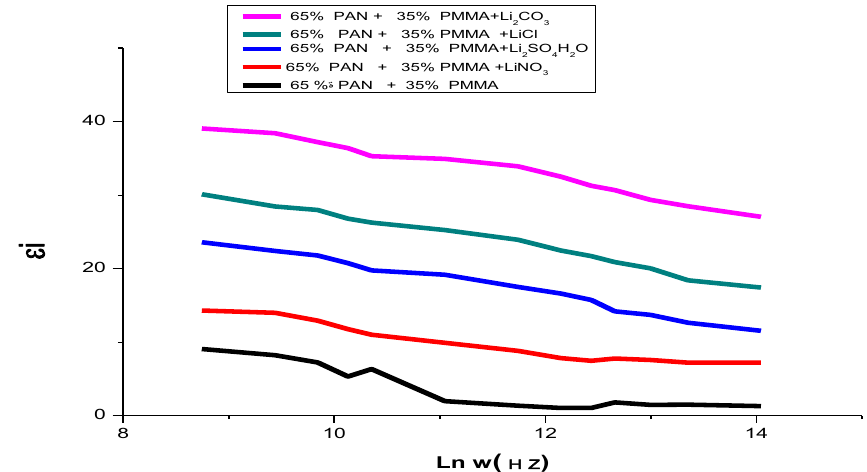
Figure 3d: The imaginary dielectric constant as function of ln (ω) of undoped